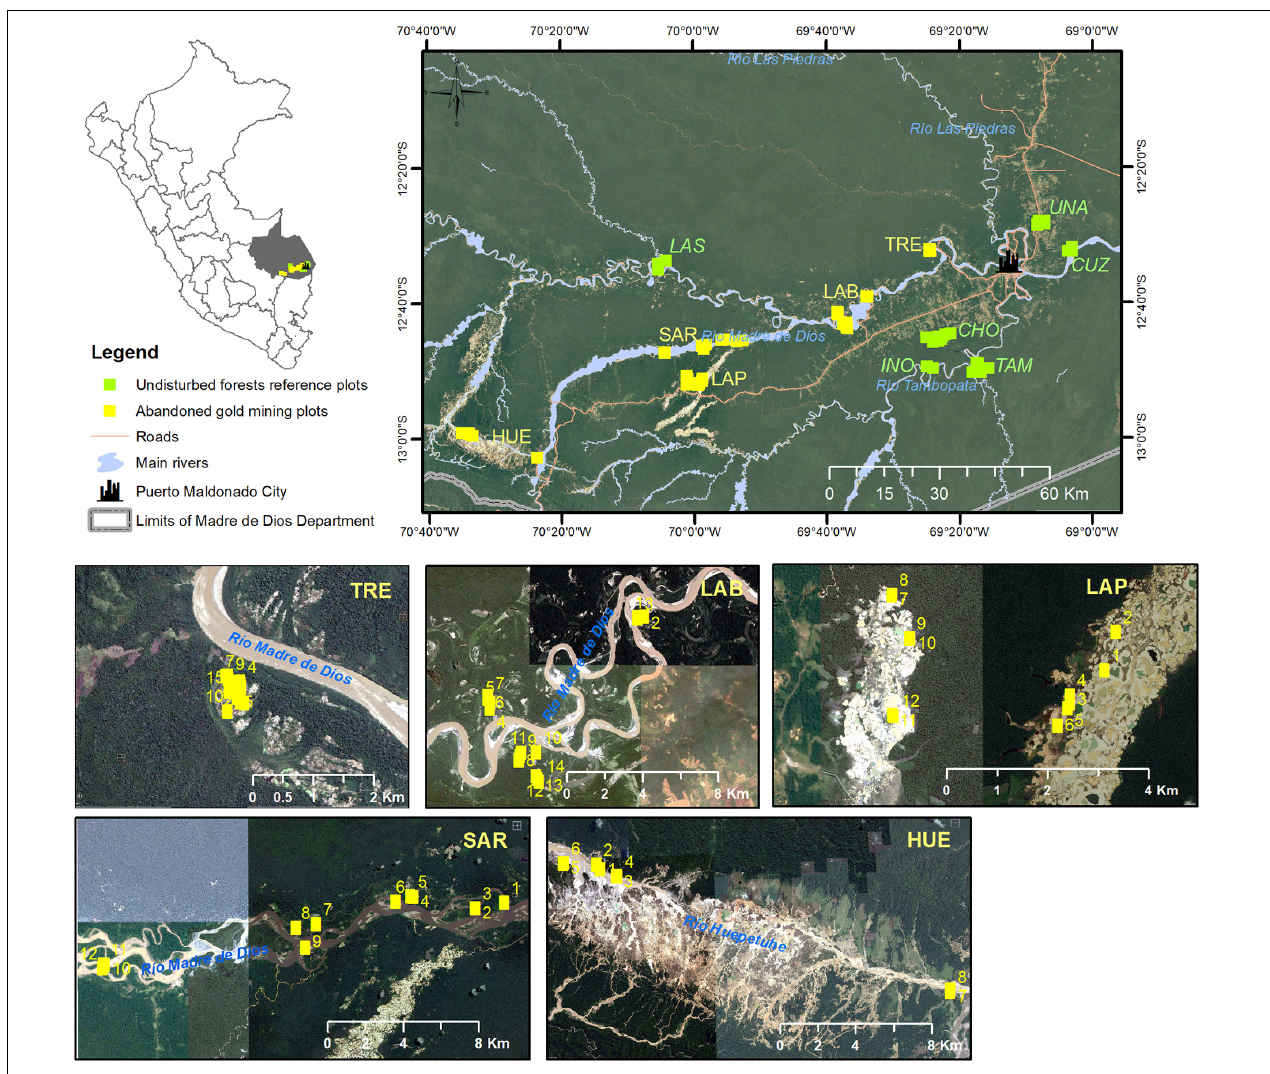
FIGURE 1 | Location of the study region including the abandoned gold mining plots (TRE, Tres Islas; LAB, Laberinto; SAR, Sarayacu; LAP, La Pampa; HUE, Huepetuhe) and undisturbed forest reference plots (UNA, Forest of the Universidad Nacional Amazonica de Madre de Dios; INO, Inotawa; CHO, Chonta; TAM, Tambopata plot zero; LAS, Jacaralia Los Amigos; CUZ, Cuzco Amazonico). The numbers within the images indicate the plot number.